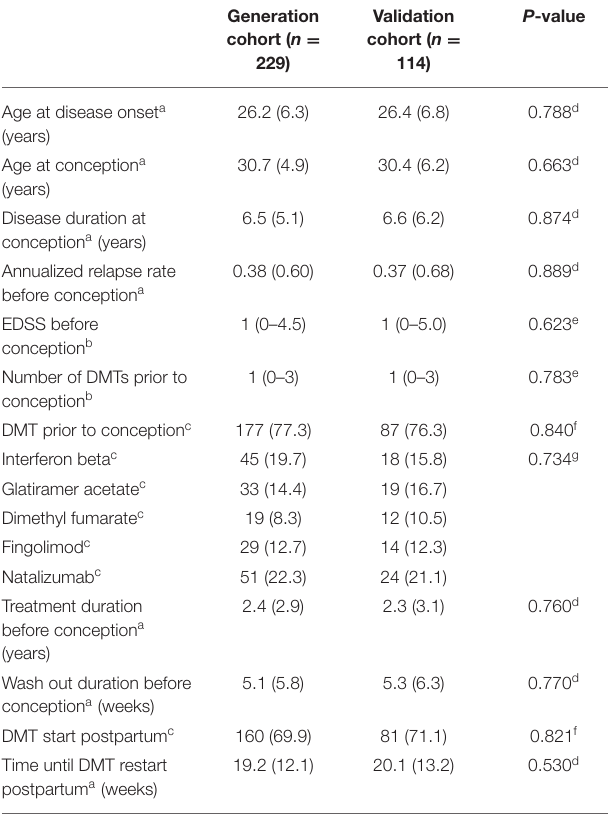
TABLE 1 | Characteristics of the generation and validation